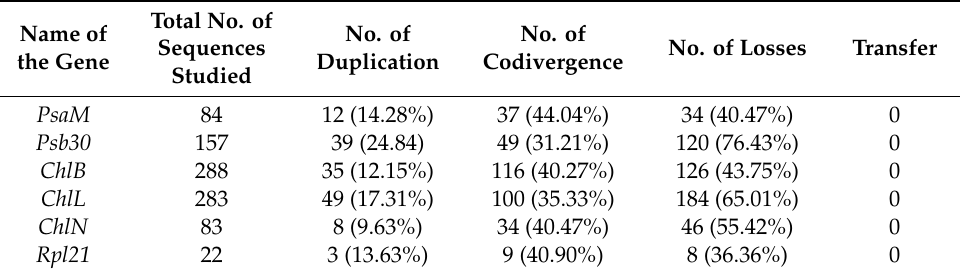
Table 1. Deletion and duplication events of PsaM, Psb30, ChlB, ChlL, ChlN , and Rpl21 genes. Analysis revealed gene loss was dominated compared to the duplication and codivergence.